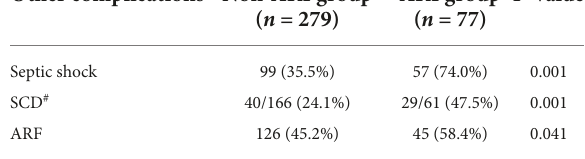
TABLE 3 Other complications between the two